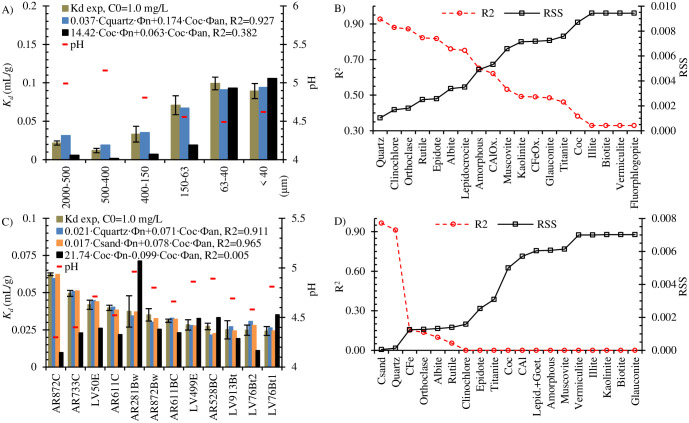
Results of modeling of adsorption in fractions of AR611C (A and B), and in 12 selected soils (pH < 5 and Coc < 0.35%) (C and D).The R2 and RSS (residual sum of squares) values (C and D) are the results of Eq (1) fitting, with the assumption that bentazone anions are adsorbed on organic matter and one of soil components listed on X-axis for adsorption of bentazone molecules.